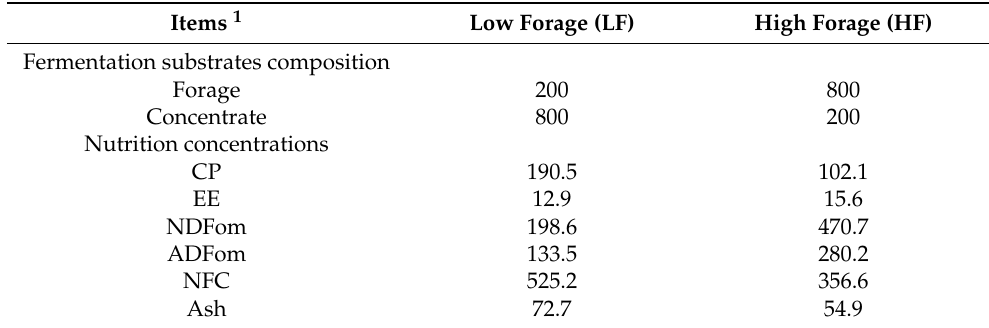
Table 2. Fermentation substrates composition and nutrient concentrations of experiment fermentation substrates (g/kg